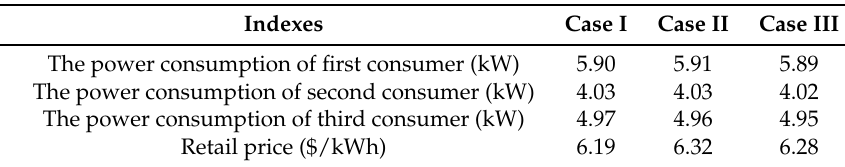
Table 4. The optimal power consumption and the retail price.